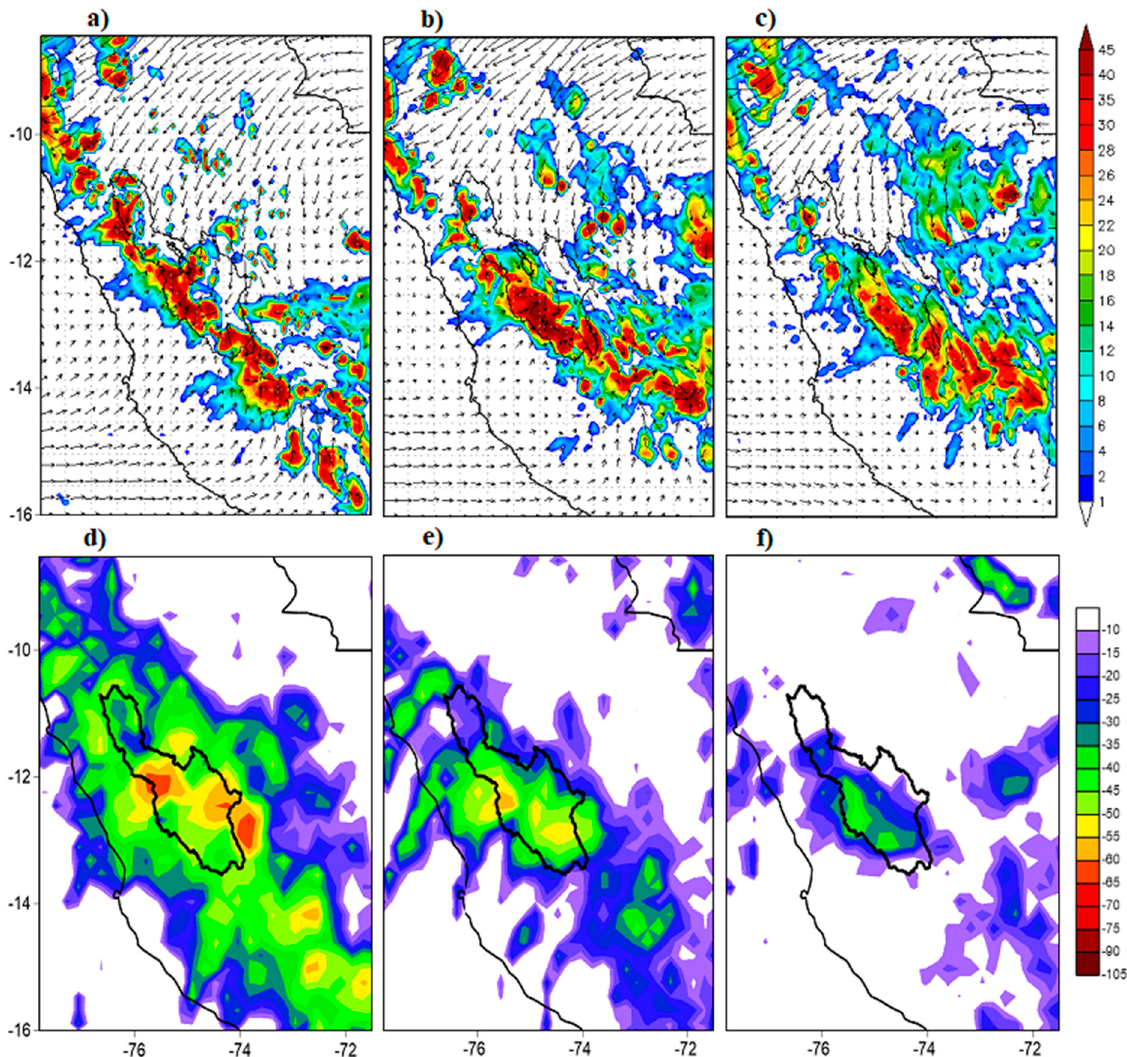
Figure 18. WRF-simulated maximum reflectivity (dBZ) and wind vector in 550 hPa (top); and corresponding GOES brightness temperature (°C) (bottom) at 22 LST of 2 February 2011 ( a , d ); and at 01 LST ( b , e ) and 04 LST ( c , f ) of 3 February 2011.